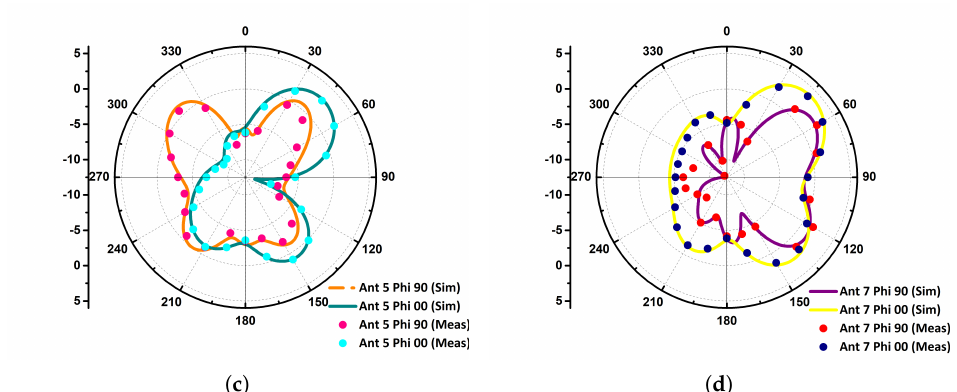
Figure 7. Simulated and measured radiation patterns for ( a ) antenna element (AE)-1, ( b ) AE-3, ( c ) AE-5, and ( d ) AE-7.